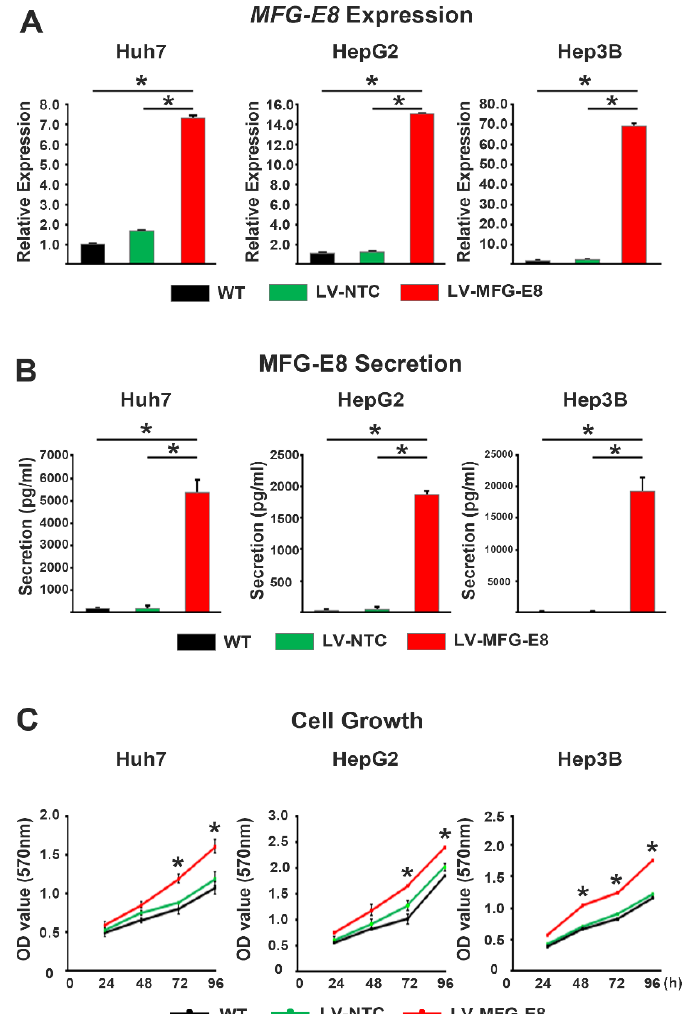
Figure 2. E ff ects of MFG-E8 overexpression on HCC cells proliferation. ( A , B ) The levels of mRNA ( A ) and secreted protein ( B ) of MFG-E8 from HCC cells after transfection with nontargeting control lentivirus (LV-NTC) or MFG-E8-overexpressing lentivirus (LV-MFG-E8). WT, untransfected cells. ( C ) Growth curves of HCC cells after transfection with LV-NTC or LV-MFG-E8. * p < 0.05, a two-tailed Student’s t -test.